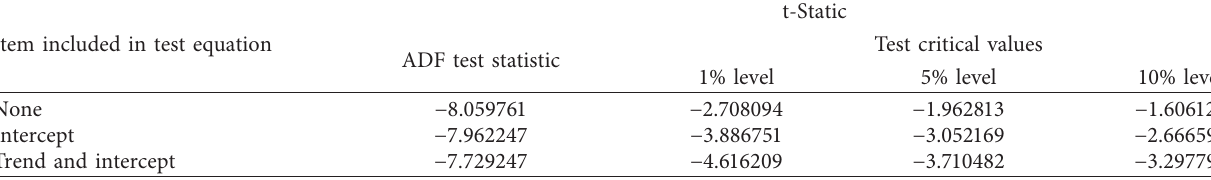
Figure 6: Part of the input dataset at station 7 of line 28. Table 2: The results of unit root tests.